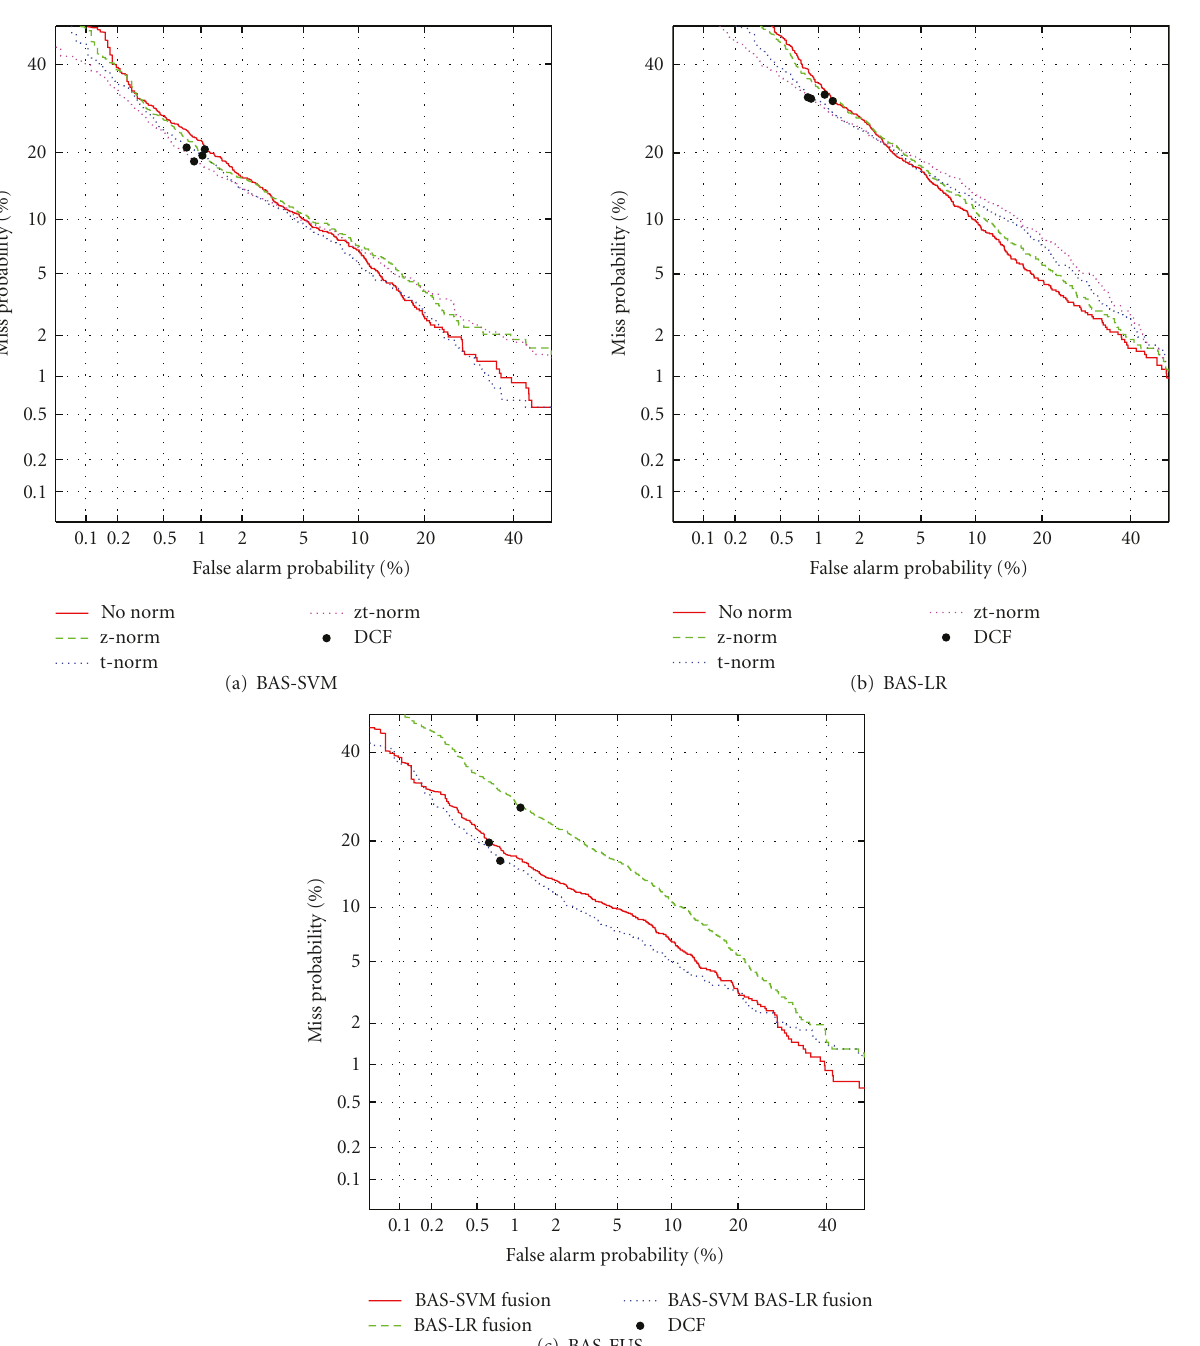
Figure 2: Speaker verification results of the baseline (BAS) systems. The DET curves for (a) the SVM and (b) LR decision criteria as well as (c) their fusion are shown. The black circle on each DET curve represents the DCF